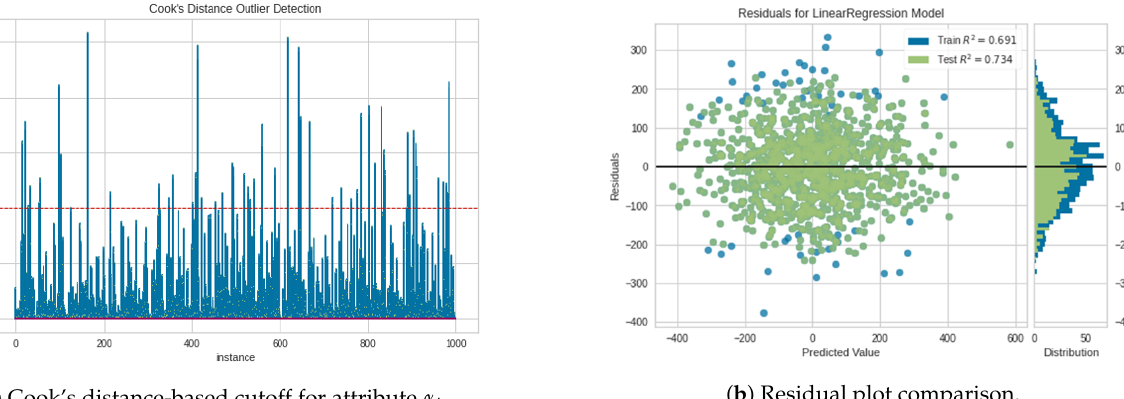
Figure 6. The effect on residual after using Cook’s distance. The residual coefficient improved after removing weakly correlated